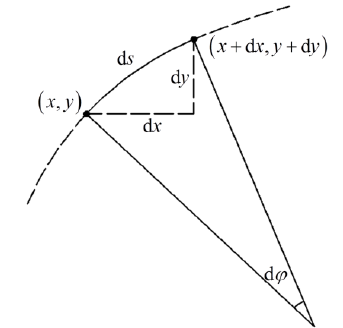
Figure 4. An infinitesimal element of the blade